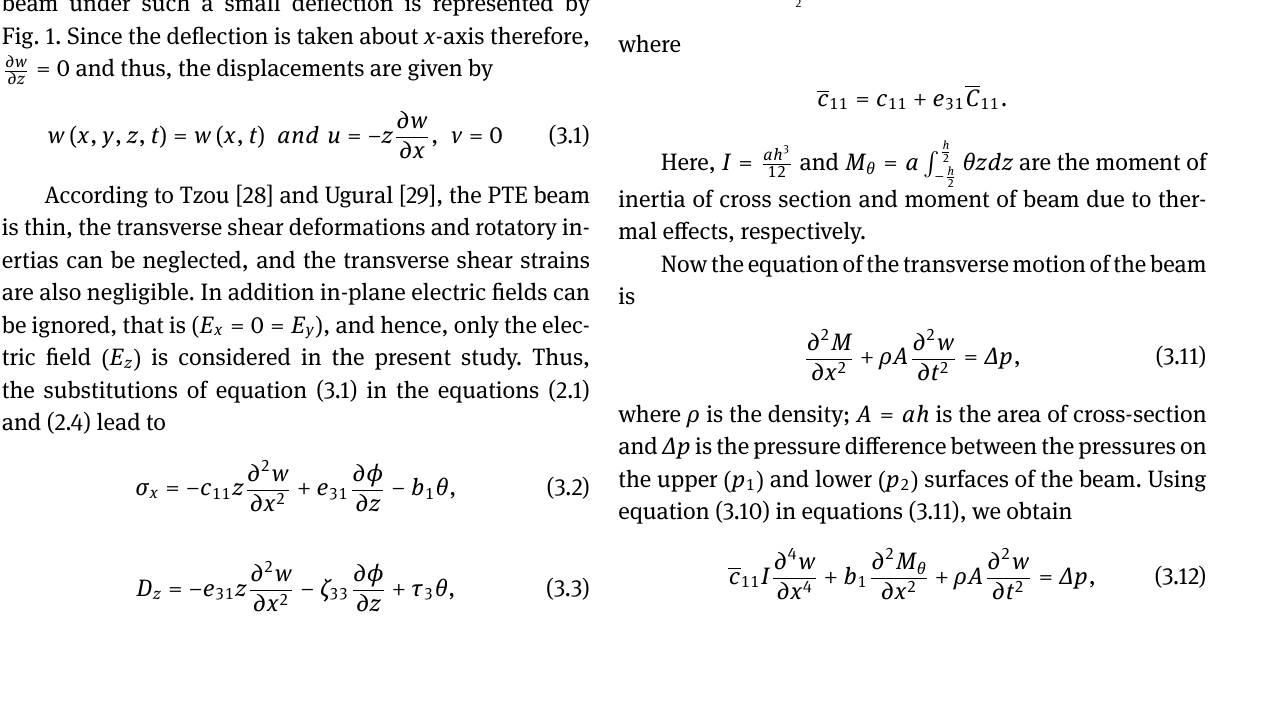
In equilibrium, the beam is unstrained, unstressed and also kept at uniform temperature T 0 . The beam un- dergoes bending vibrations of small amplitude about the x -axis such that the deflection is consistent with the linear Euler–Bernoulli theory. That is, any plane cross-section initially perpendicular to axis of beam remains, plane and perpendicular to the neutral surface during bending. The beam under such a small deflection is represented by Fig. 1. Since the deflection is taken about x -axis therefore, ∂w = 0 and thus, the displacements are given ∂z